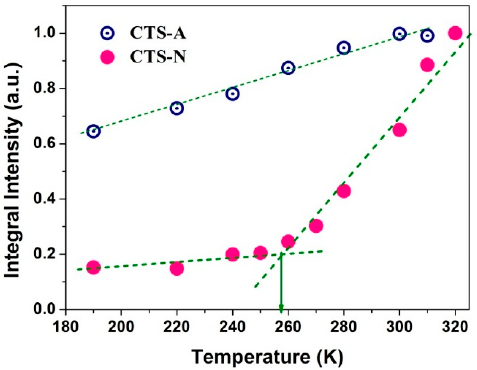
Figure 6. Integral signal intensity of the saturation recovery quadrupolar echo 2 H spectra from Figure 4b,d. The onset of motion of the weakly bound matrix water is shown at 260 K.